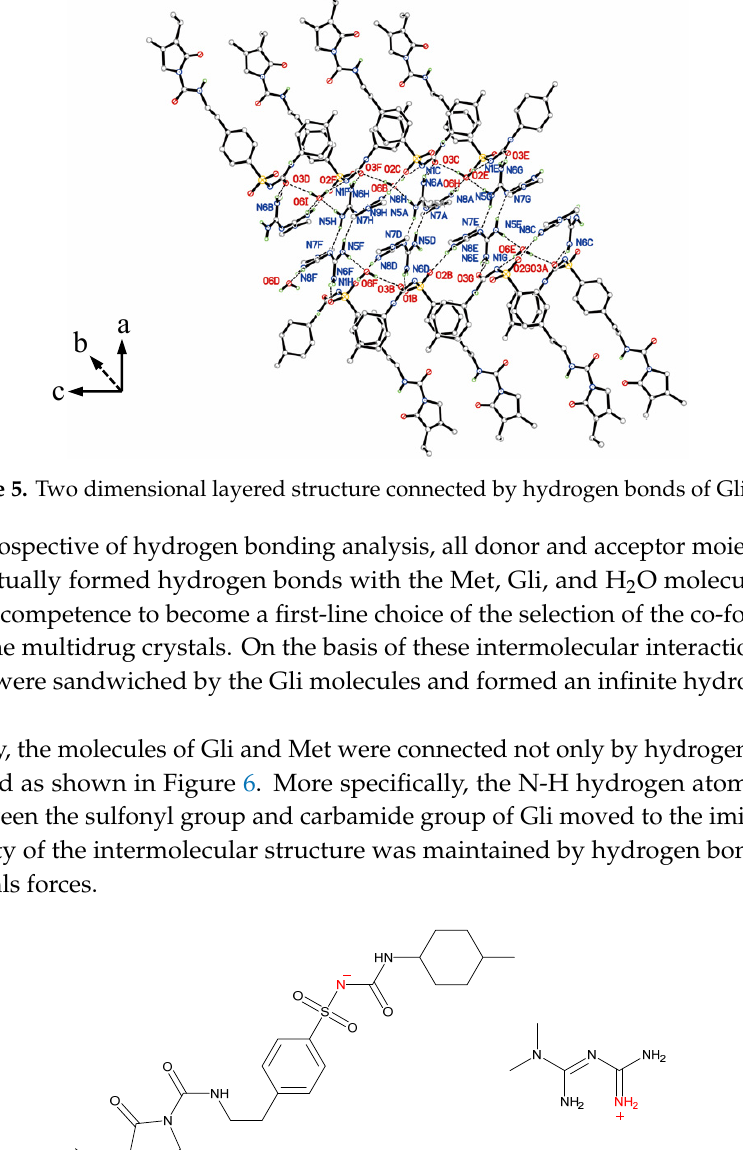
Figure 7. Infrared spectra of Gli ‐ Met, Met and Gli. 2.2. The Characterization of Physicochemical Properties The first physicochemical evaluation of Gli ‐ Met was through dissolution tests. Improving the poor dissolution of Gli is necessary because it is classified as a class II molecule, according to the BCS. Additionally, since Gli is a weak acid, the absorption of Gli in the gastrointestinal tract occurs predominantly in the stomach. Therefore, we conducted this experiment in an acidic medium (pH = 1). As shown in Figure 8 and Table S1, the dissolution rate of Gli ‐ Met was significantly higher than that of the Gli raw material. Additionally, the released amounts were consistently higher for Gli ‐ Met than for Gli alone during the 90 min period. Finally, the dissolution rate of Gli ‐ Met reached equilibrium and peaked at its highest value around 80%.